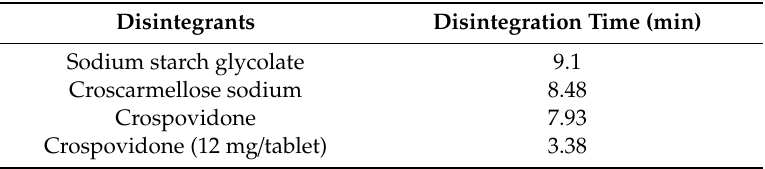
Table 3. Disintegration time of the clopidogrel bisulfate core tablet in water at 37 ◦